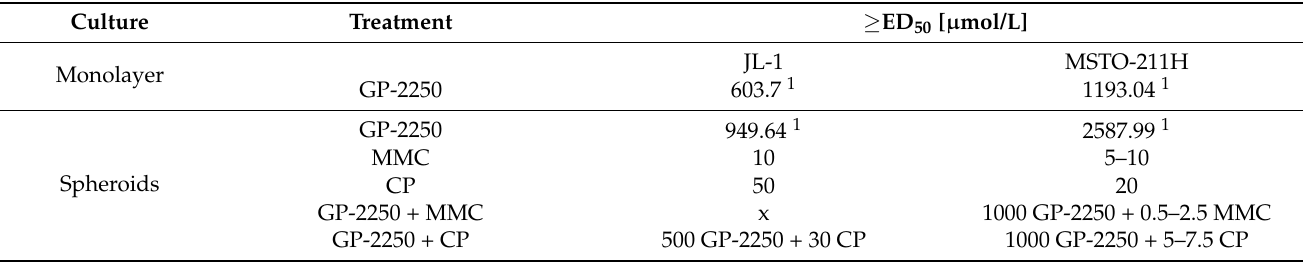
Table 1. Doses needed to achieve a decline of viable cells by 50% (ED 50 ) or more after a 48 h treatment